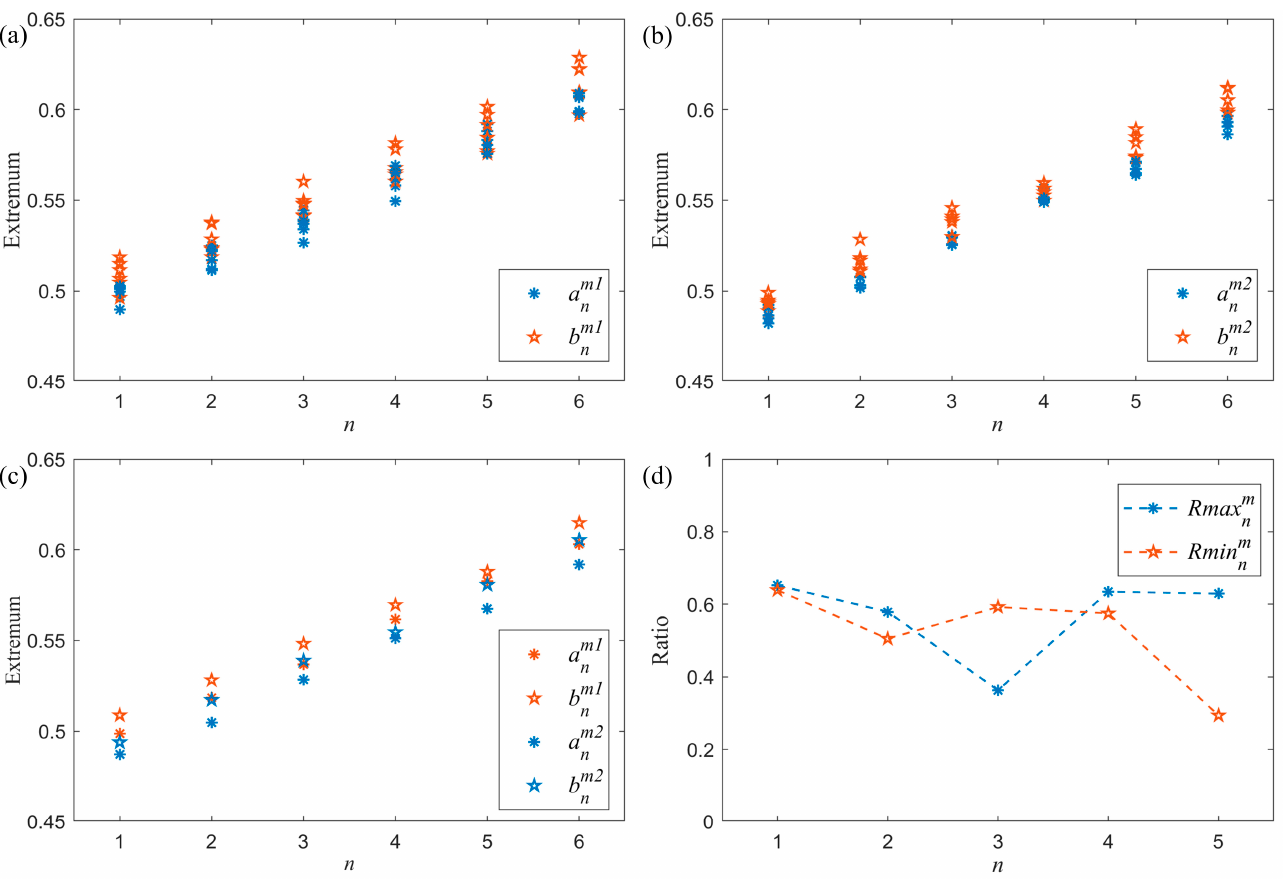
Figure 15. Measurement results of wavefront-division interference experiments at high signal-to-noise ratios. ( a ) Extrema of the normalized interference term I ∆ ( b ) extrema of the normalized interference term I ∆ corresponding extrema of the normalized interference terms I ∆ and m Rmax and m Rmin calculated from the extrema.